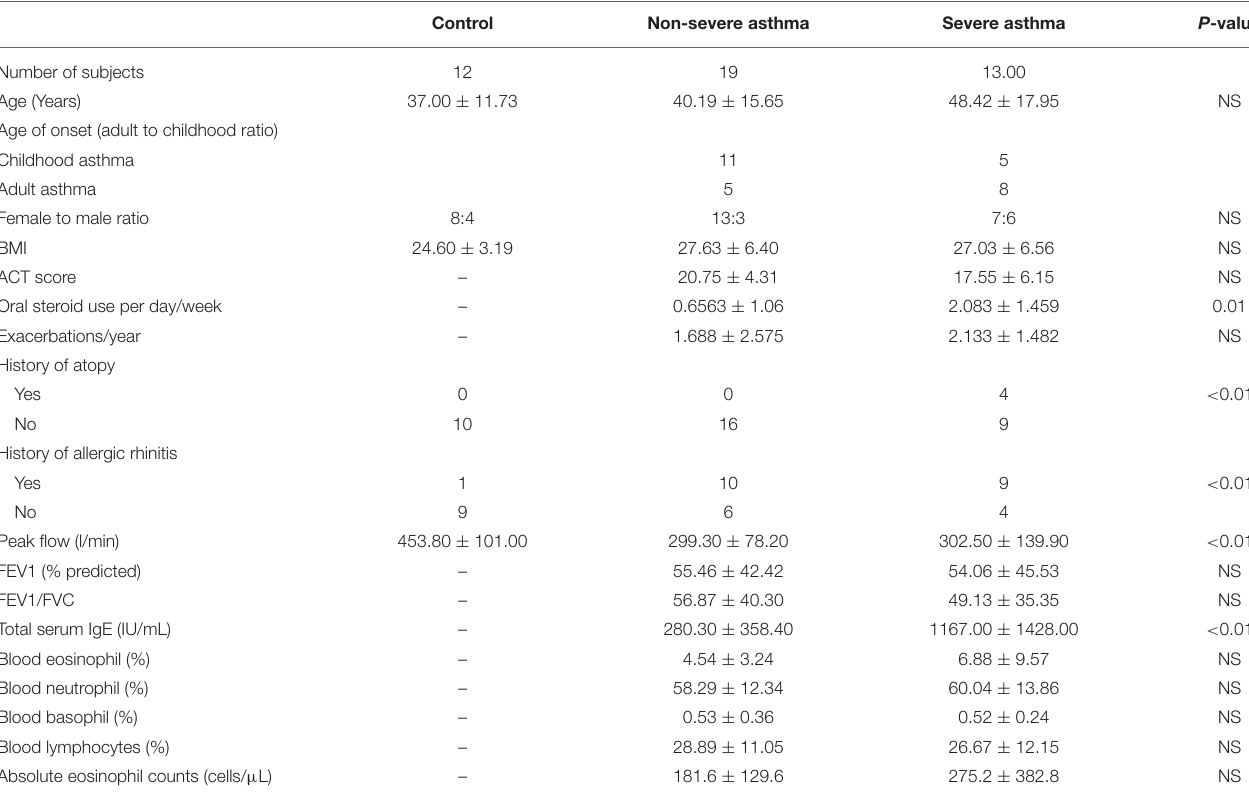
TABLE 1 | Characteristics of the cohort 1 subjects with asthma and healthy controls. Control Non-severe